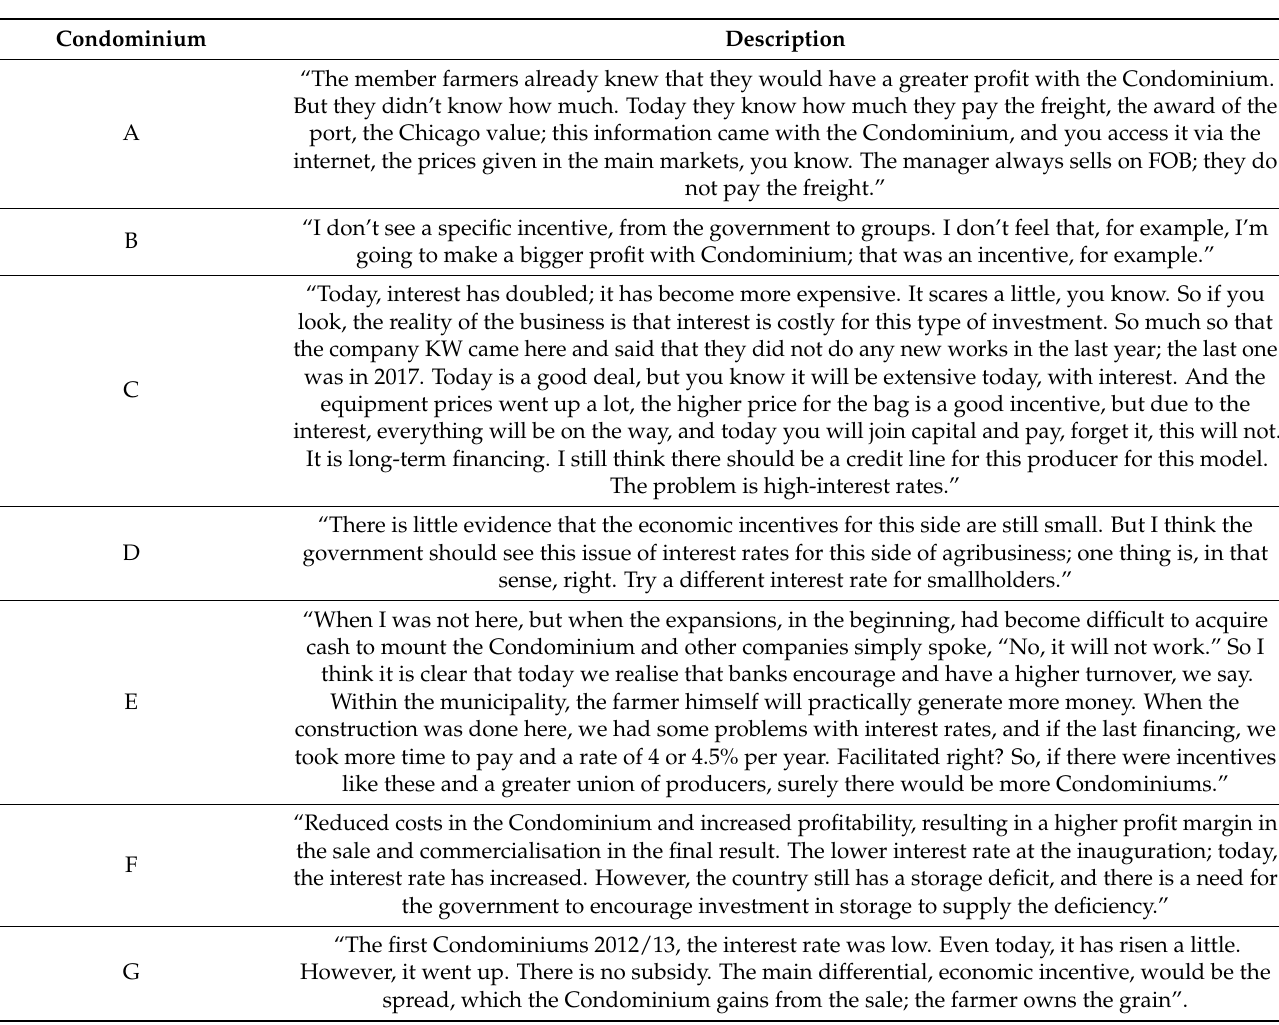
Table 3. Interviewees’ statements about the Economic Incentives of the rural collective model Condominiums of Rural